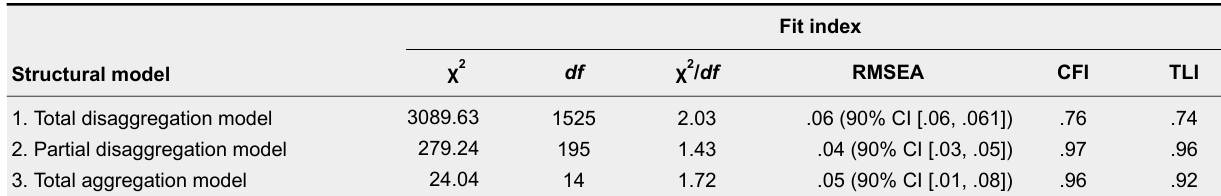
Comparison of Fit Indices of the Total Disaggregation Model, Partial Disaggregation Model, and Total Aggregation